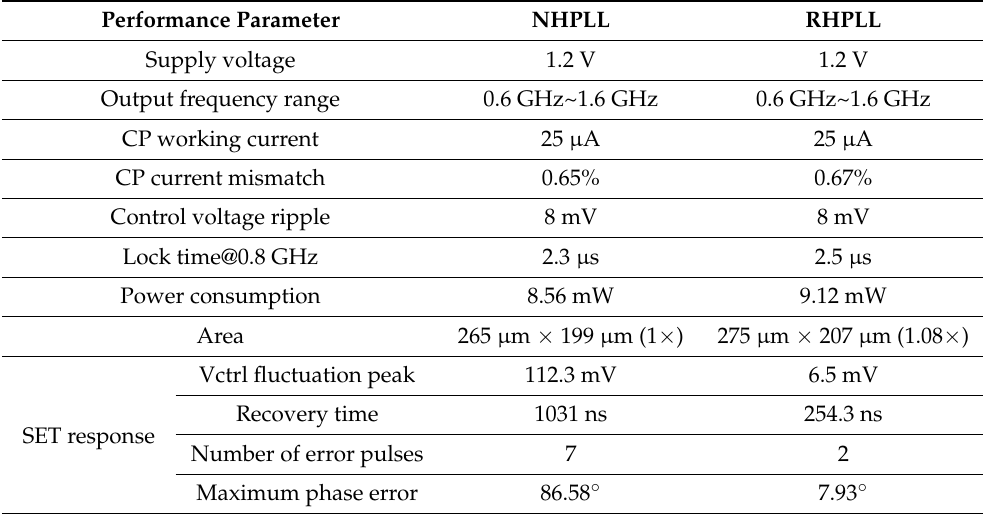
Table 1. Performance comparison of the PLL before and after hardening.